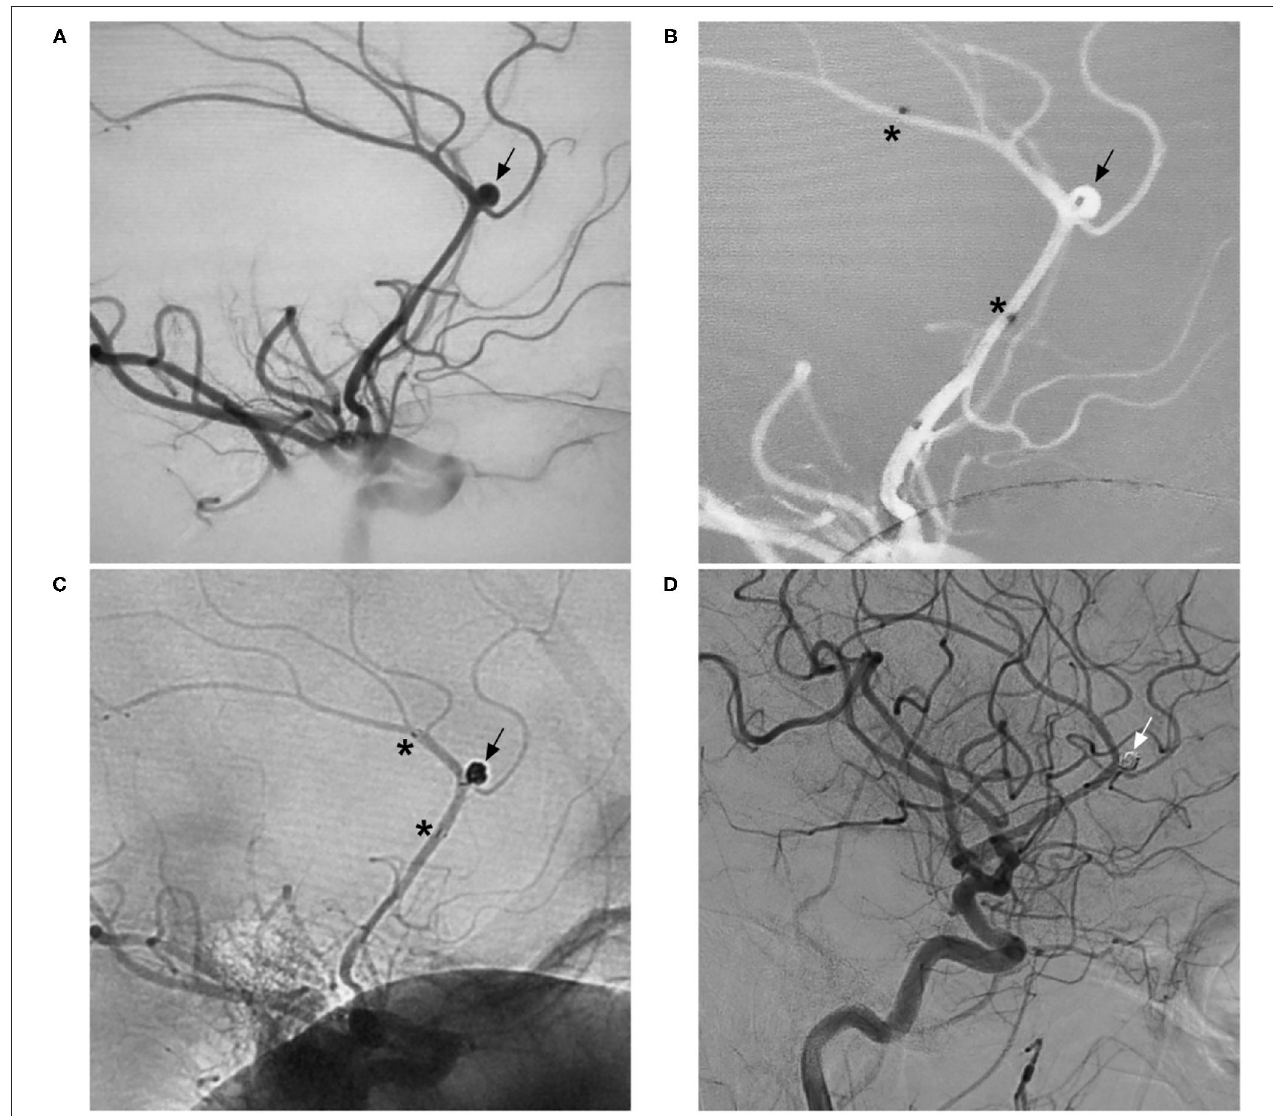
FIGURE 12 | Distal aneurysm coiling assisted by the NAS. (A) DSA of the ICA showing an aneurysm (arrow) in the distal ACA. (B) Map showing the positioning of the NAS delivery microcatheter (the asterisks show the proximal and distal markers) and coil delivery microcatheter (the arrow shows the tip). (C) Unsubtracted DSA of the ICA showing coiling of the aneurysm (arrow) under NAS assistance (the asterisks show the proximal and distal markers). (D) Follow-up DSA of the ICA showing complete occlusion of the aneurysm (arrow). ACA, anterior cerebral artery; DSA, digital subtraction angiography; ICA, internal carotid artery; NAS, Neuroform Atlas